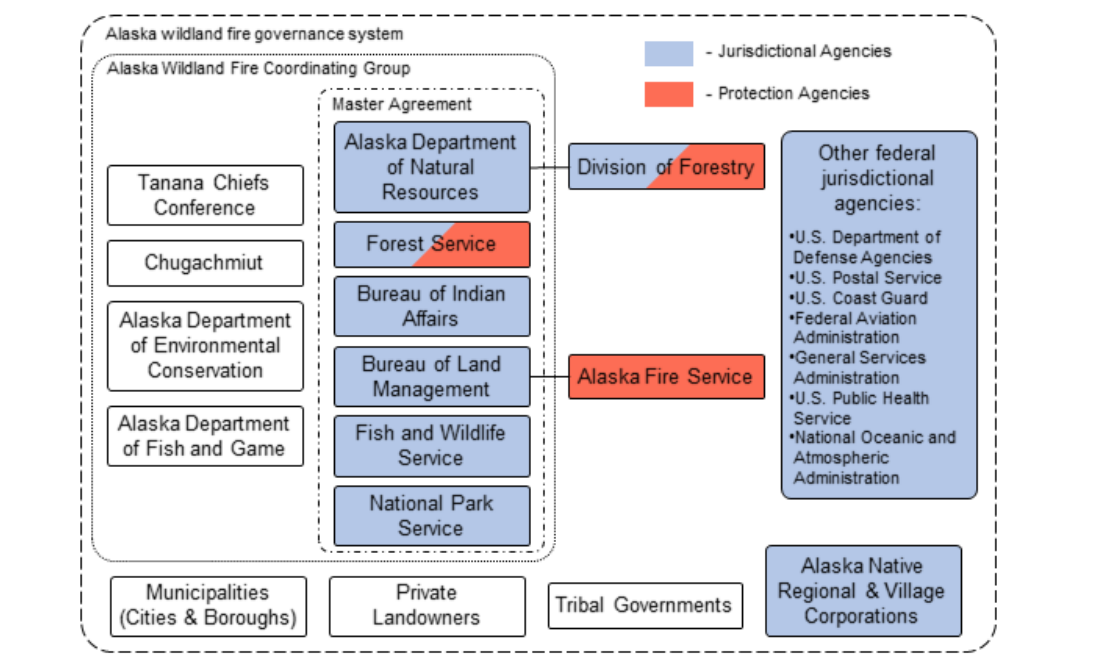
Fig. 1 . Alaska Wildland Fire Governance System Structure. Boxes represent organizations, agencies, and stakeholders involved in wildland fire governance in Alaska (AWFCG 2017). The outermost dotted line encloses all these actors, and thus represents what we call the “Alaska wildland fire governance system” in general. Bridging organizations, regional and local level collaborative groups, and multilevel networks, as we describe in our results and discussion, occur within this broader governance system. The inner dotted lines enclose the two primary statewide bridging organizations, the Alaska Wildland Fire Coordinating Group and the Alaska Master Cooperative Wildland Fire Management and Stafford Act Agreement (i.e., “Master Agreement”).